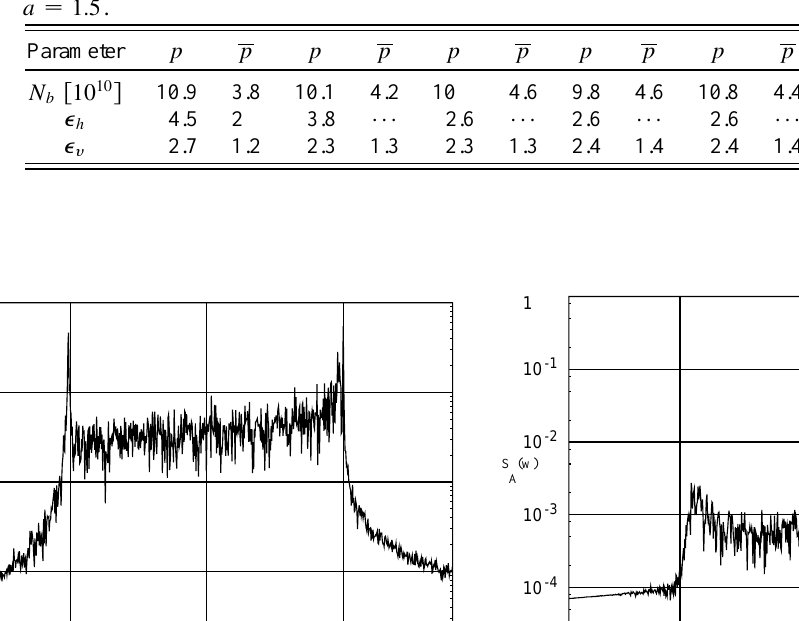
(cid:1) rN (cid:2) 1 (cid:3) (cid:1) s (cid:2) 1 (cid:3) (cid:1) 1 , s (cid:2) 2 (cid:3) (cid:1) s (cid:2) 1 (cid:3) (cid:1) 1 . , s (cid:2) 2 (cid:3) p p x x y y